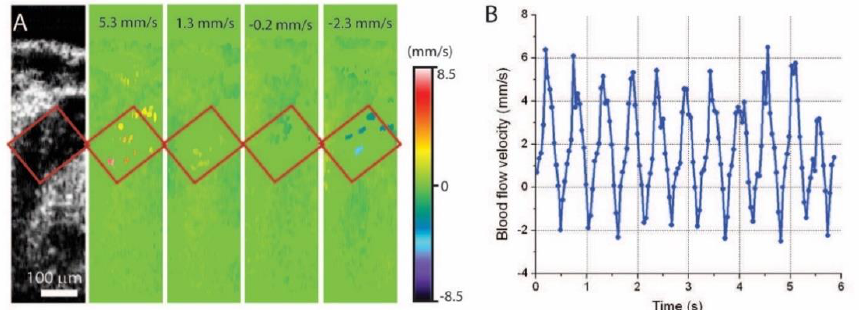
Figure 6. Doppler OCT velocity measurements from individual blood cells in E8.5 mouse embryo. ( A ) Structural and corresponding color coded Doppler velocity images acquired at different phases of the heartbeat cycle. Green corresponds to zero velocity. Individual blood cells are distinguishable in the dorsal aorta. ( B ) Average blood flow velocity as a function of time in the corresponding area of the dorsal aorta. Reproduced with permission from [70].